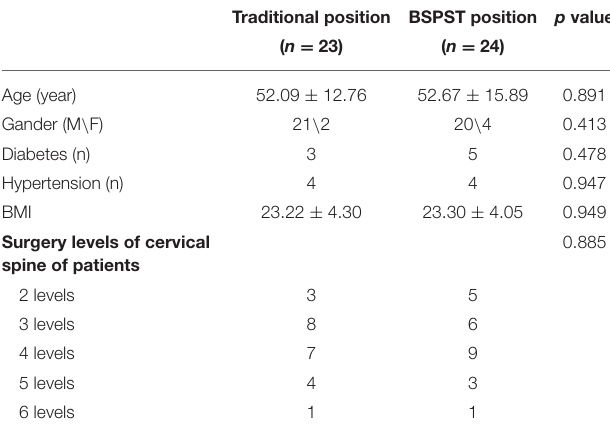
TABLE 1 | General preoperative information in two